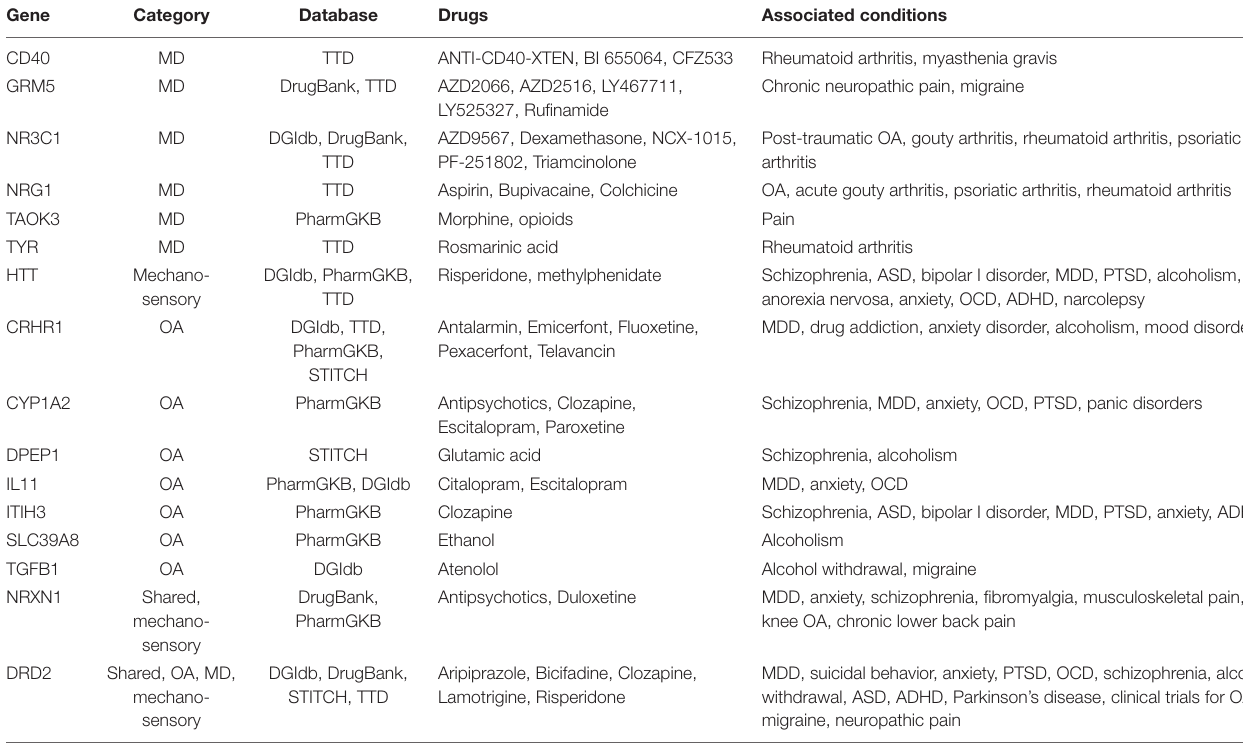
TABLE 3 | Drug-gene interactions for OA/MD risk and “mechanosensory behavior”